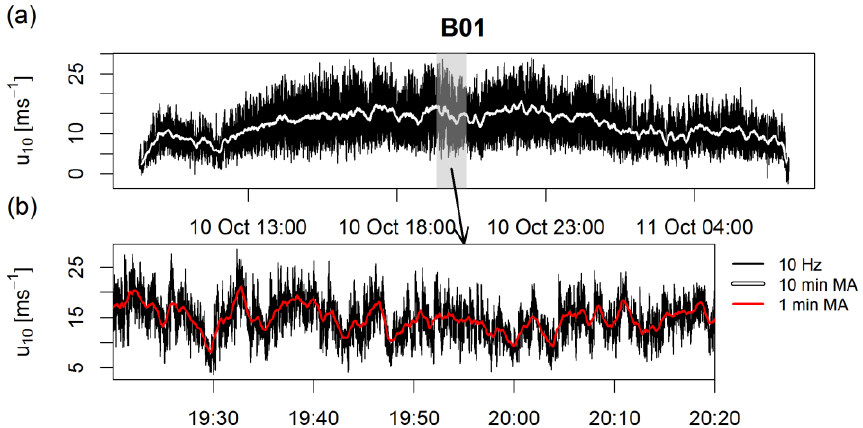
Figure 5. ( a ) Bora episode (B01) streamwise wind speed ( u ) downsampled to 10 Hz. The white line is the 10-min moving average. ( b ) The zoomed 60 min of the same data with 1-min moving average is in red color.